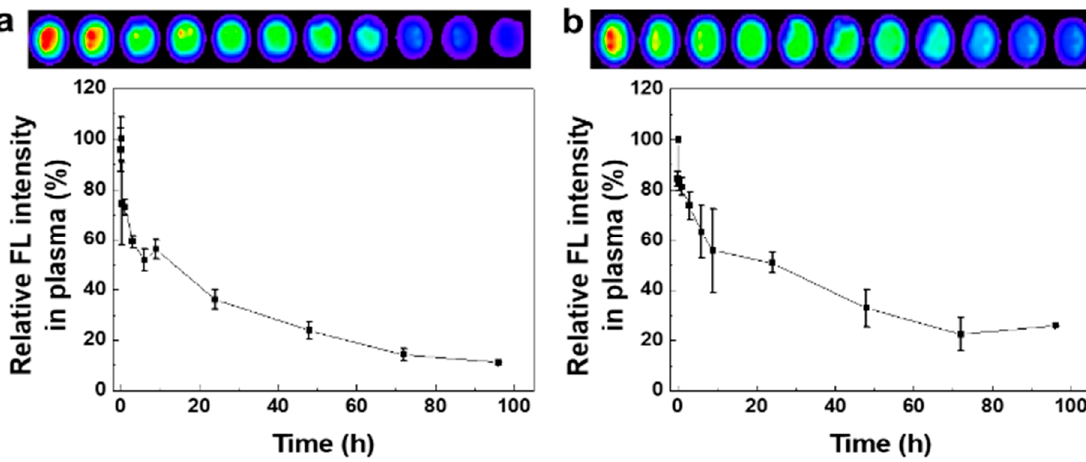
Figure 3. The pharmacokinetic analysis of ICG-CNPs using rabbit serum ( n = 3) and mouse serum ( n = 3). The NIRF signals from ( a ) mouse and ( b ) rabbit blood. The half-life of NIRF signals was calculated at 3.25 ± 0.36 h and 4.73 ± 0.2 h in mouse blood and rabbit blood, respectively. ( n = 3, mean ± SD).